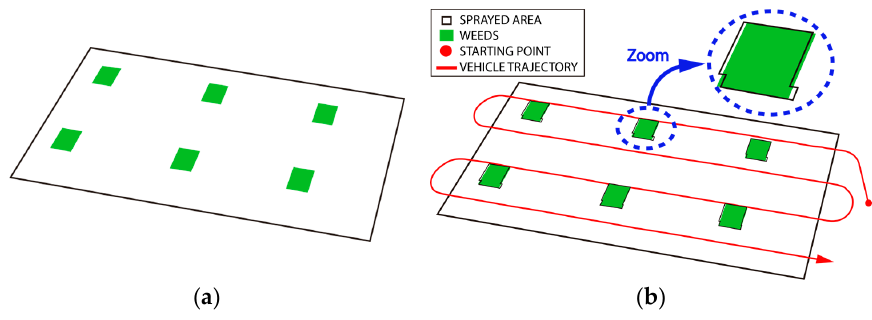
Figure 11. ( a ) Weed distribution map; ( b ) Ground mission plan and sprayed surface.